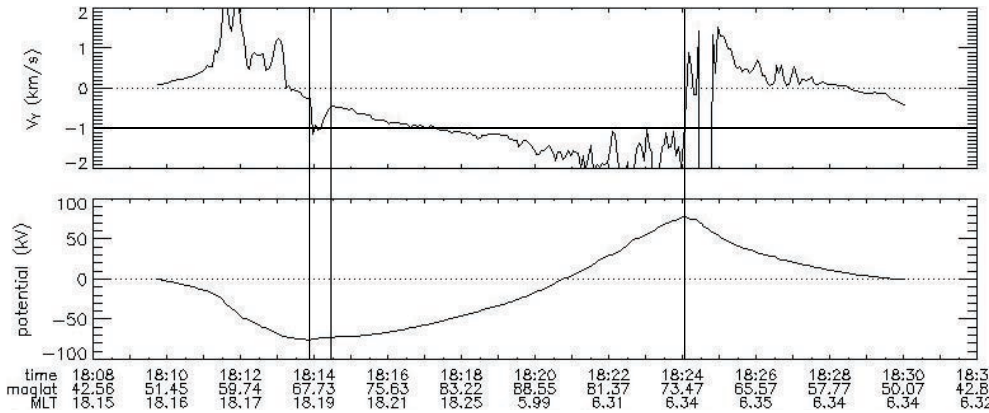
Fig. 13. DMSP F13 cross-track ion drift ( V y ) and electrostatic potential curves for the interval 18:08–18:32UT. Flow channel FC 3 at the dusk side polar cap boundary is marked by the two first guidelines. The third guideline marks the polar cap boundary on the dawn